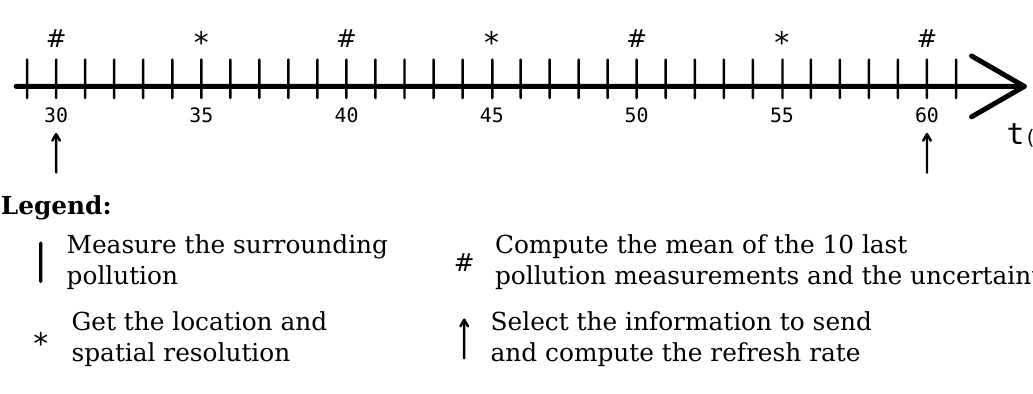
Figure 6. Example of pollution measurements sequence executed in a